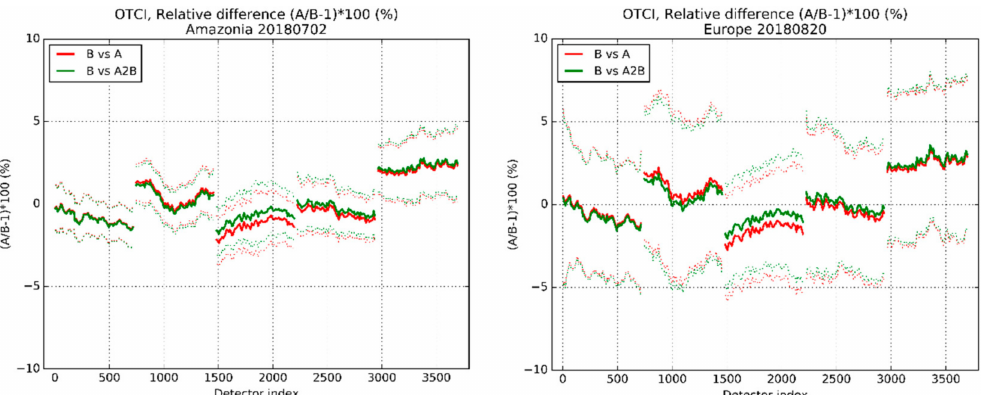
Figure 8. OTCI relative di ff erences of OLCI-A baseline (“A”, red) and harmonised (“A2B”, green) with OLCI-B for Amazonia ( left ) and Europe ( right ). Median and dispersion per OLCI